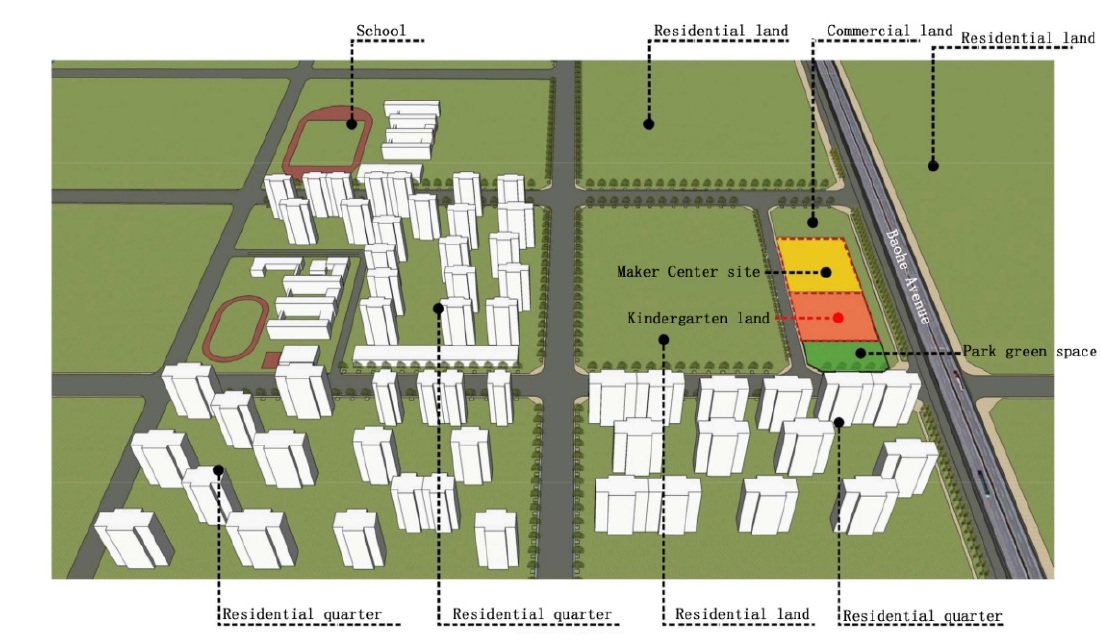
Fig. 1 Schematic diagram of the surrounding environment of the